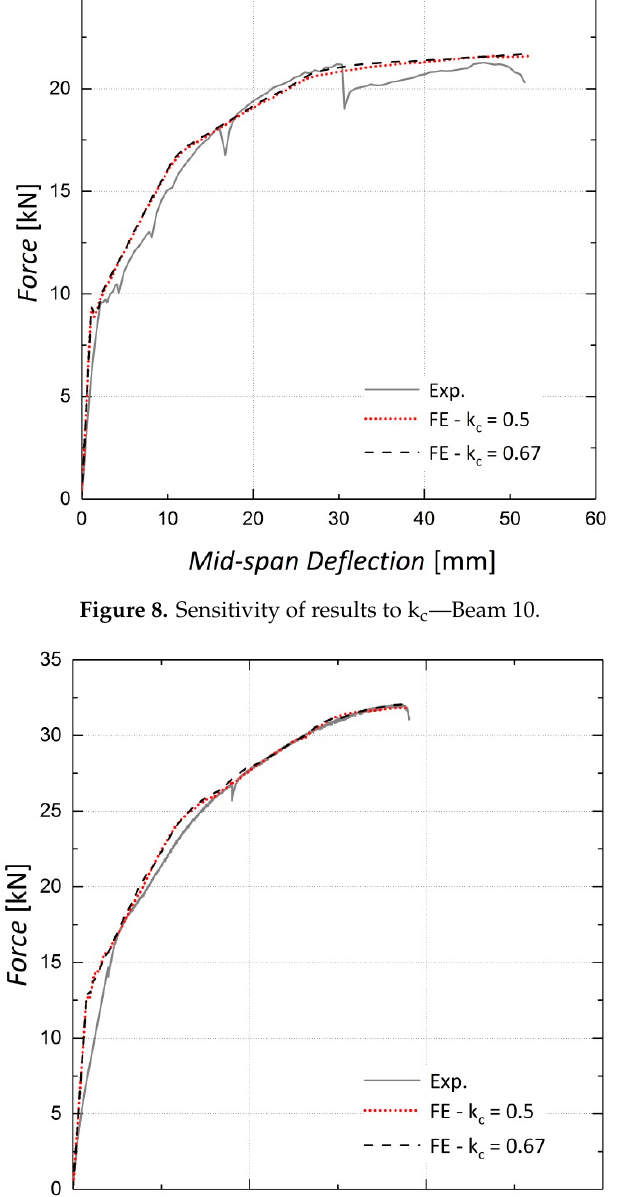
Figure 9. Sensitivity of results to k c —Beam 11.